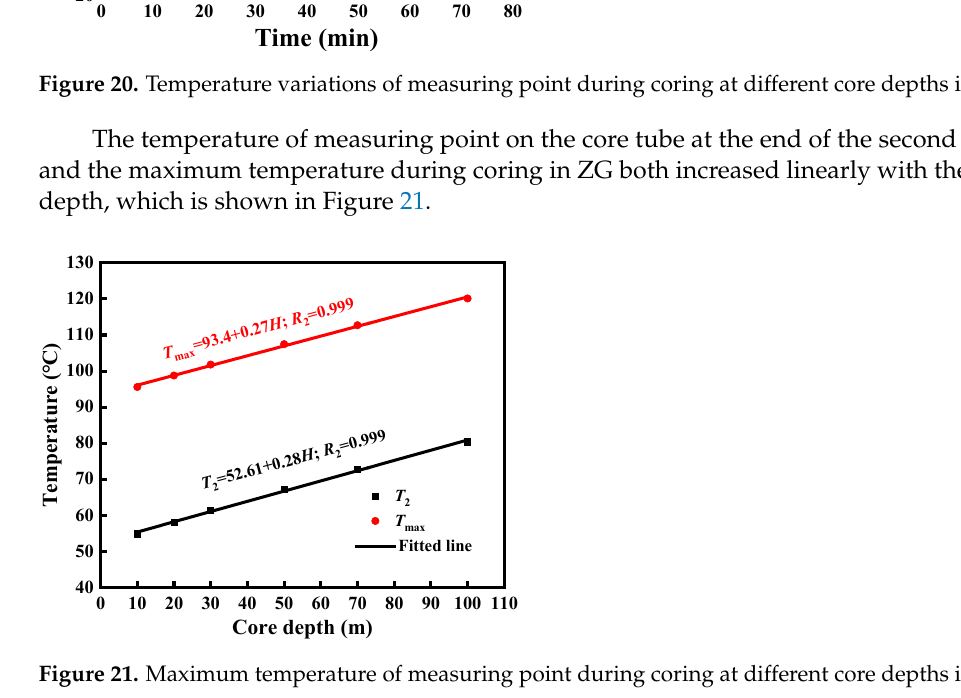
Figure 21. Maximum temperature of measuring point during coring at different core depths in ZG.